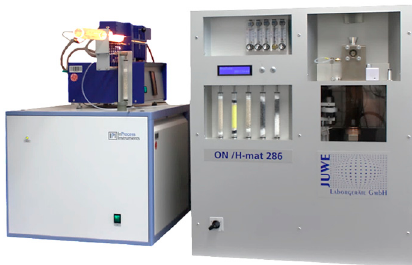
Figure 6. G8 Galileo, coupled with a quadrupole mass spectrometer. Table 4. Measurement parameters of the TDA for the characterization of hydrogen uptake, the determination of Ea and D 0 and the empirical verification of the desorption time.